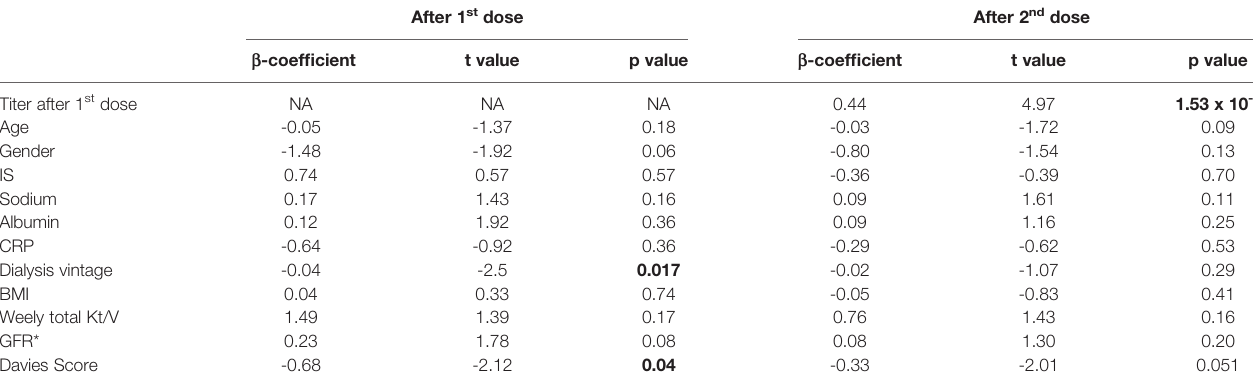
TABLE 3 | Effects of covariates on antibody titers after the fi rst and the second dose of mRNA-1273 SARS-CoV-2 vaccine (univariate analysis). After 1 st dose